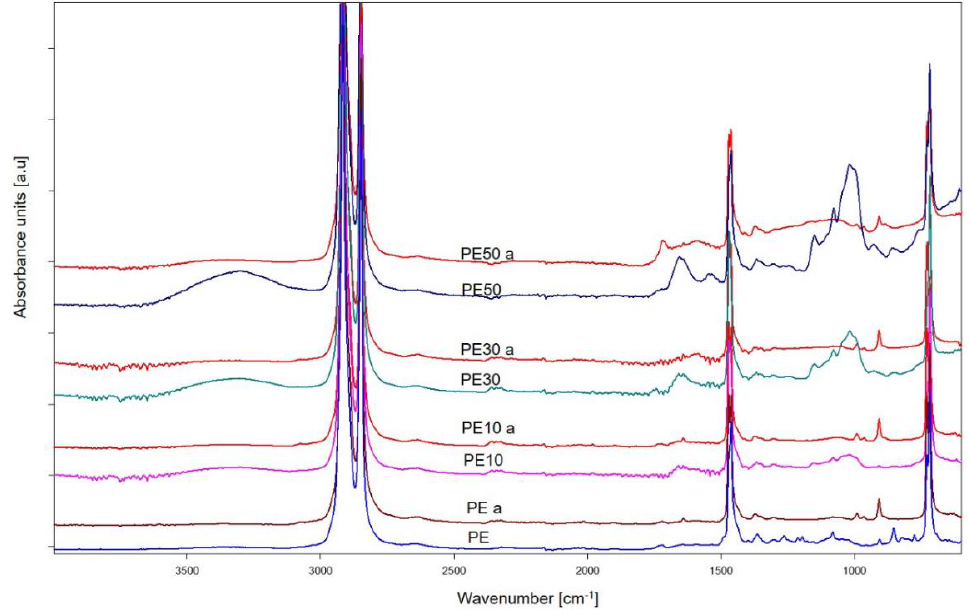
Figure 13. Spectra of samples made of polyethylene and its composition with bran, before and after the flammability test (a).